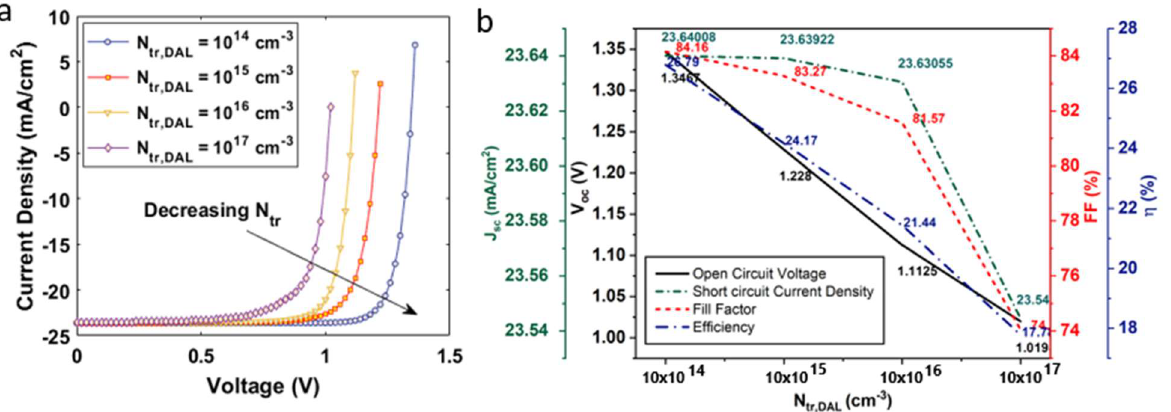
Figure 6. ( a ) Current density–voltage characteristics of a solar cell under auger recombination; ( b ) influence of defect density-assisted SRH recombination on the open circuit voltage, short circuit current density, fill factor, and efficiency of the solar cell.